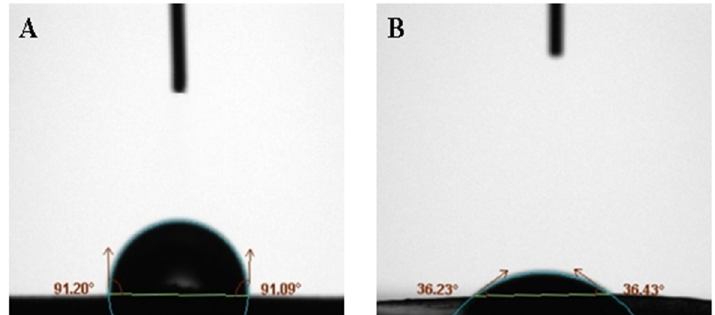
Figure 5 . The contrast diagram of effect of surfactant on serum scattering power: ( A ) without surfactant; ( B ) with 35 μ L surfactant Tween-80.